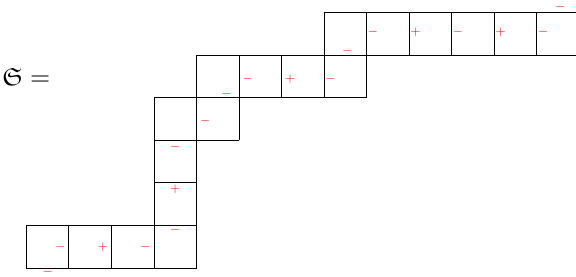
Figure 3. A sequence S k associated with the snake graph S f ( 4,4,2,2,4,2,6 )